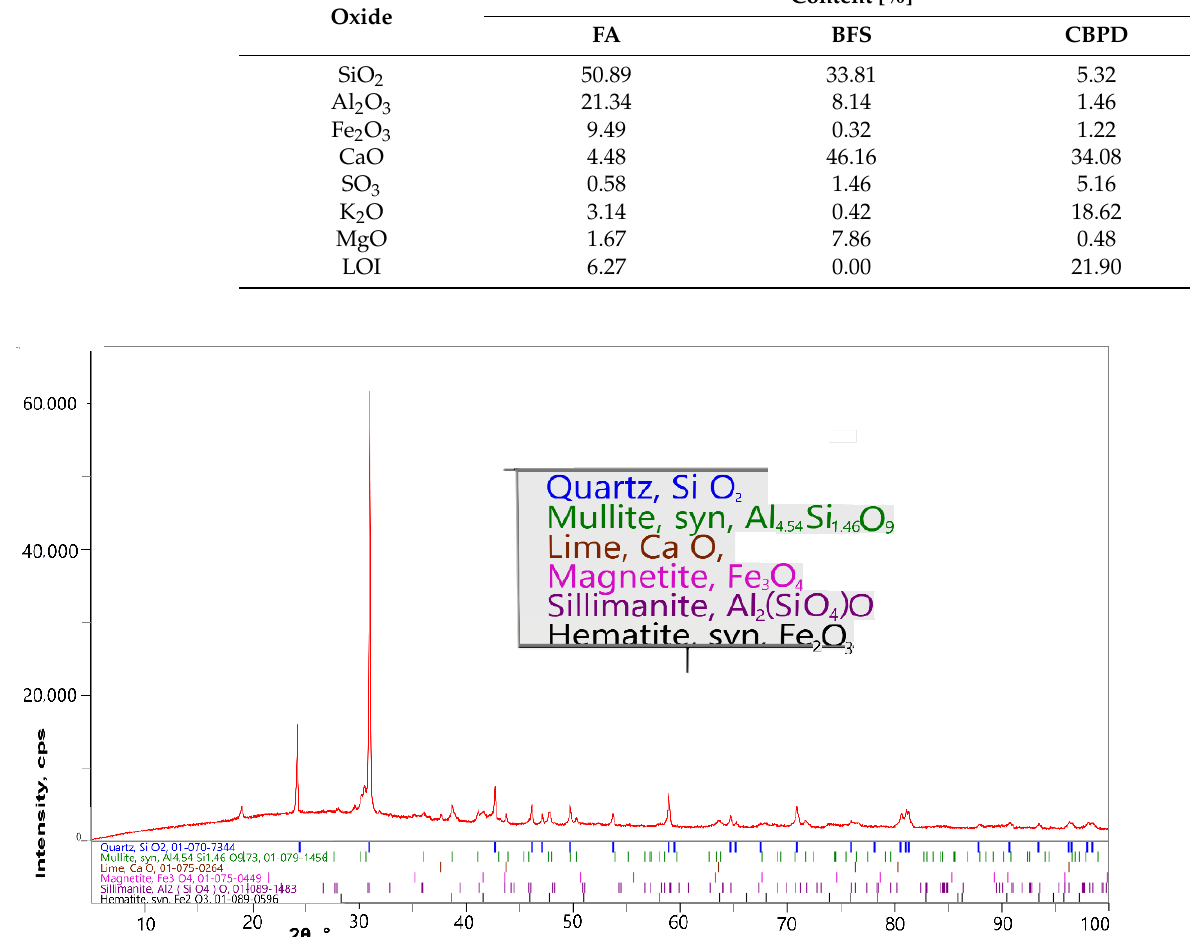
Figure 1. Mineralogical composition of FA determined by X-ray diffraction (XRD).